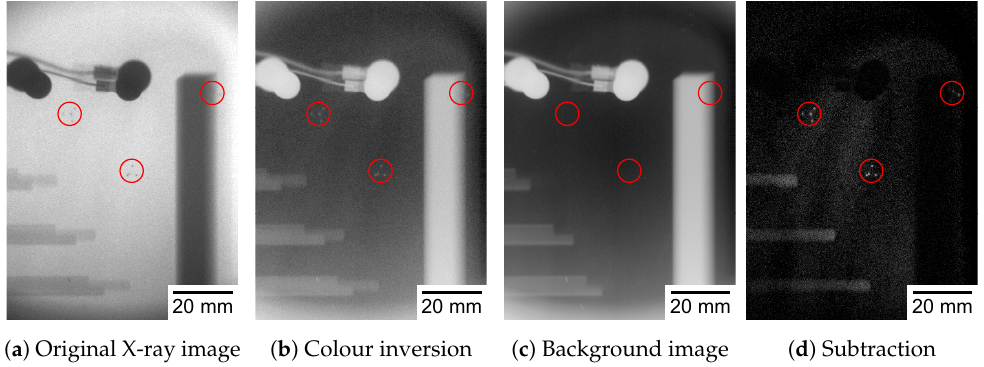
Figure 6. Image pre-processing before detecting the tracer particles, particularly the four metal beads of each tracer: ( a ) the original grey-scale image ( b ) was colour-inverted and ( c ) the background image acquired without tracer particles ( d ) was subtracted. The positions of the three different tracers are highlighted by the red circles in each